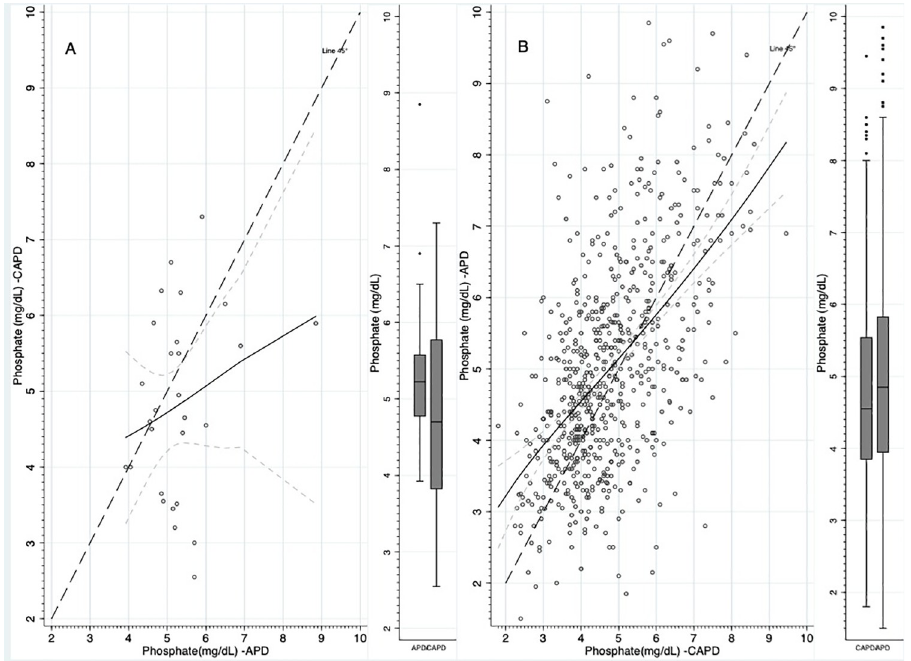
Fig 3. Phosphate serum levels. A: Starting on CAPD and switching to APD, B: Starting on APD and switching to CAPD. The continuous black line was predicted with fractional polynomials. The dashed gray lines are the 95% confidence intervals for continuous black line. The boxplots depict the mean value, interquartile range and min. max. values of phosphate during the time on CAPD and APD.